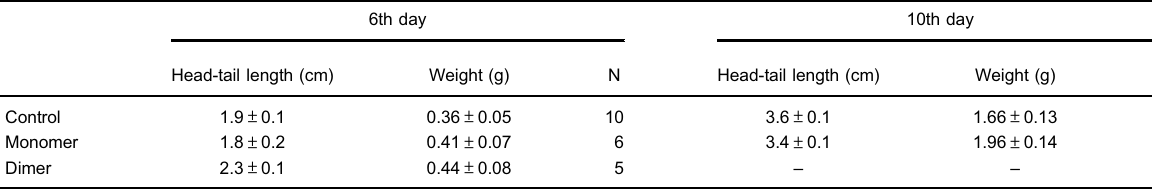
Table 1. Effects of the b 2 GPI subfractions on embryo